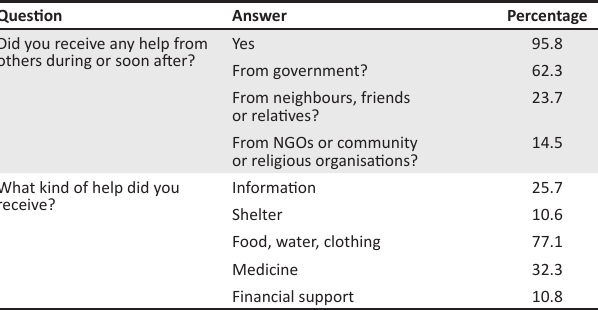
TABLE 4: Help received from others.